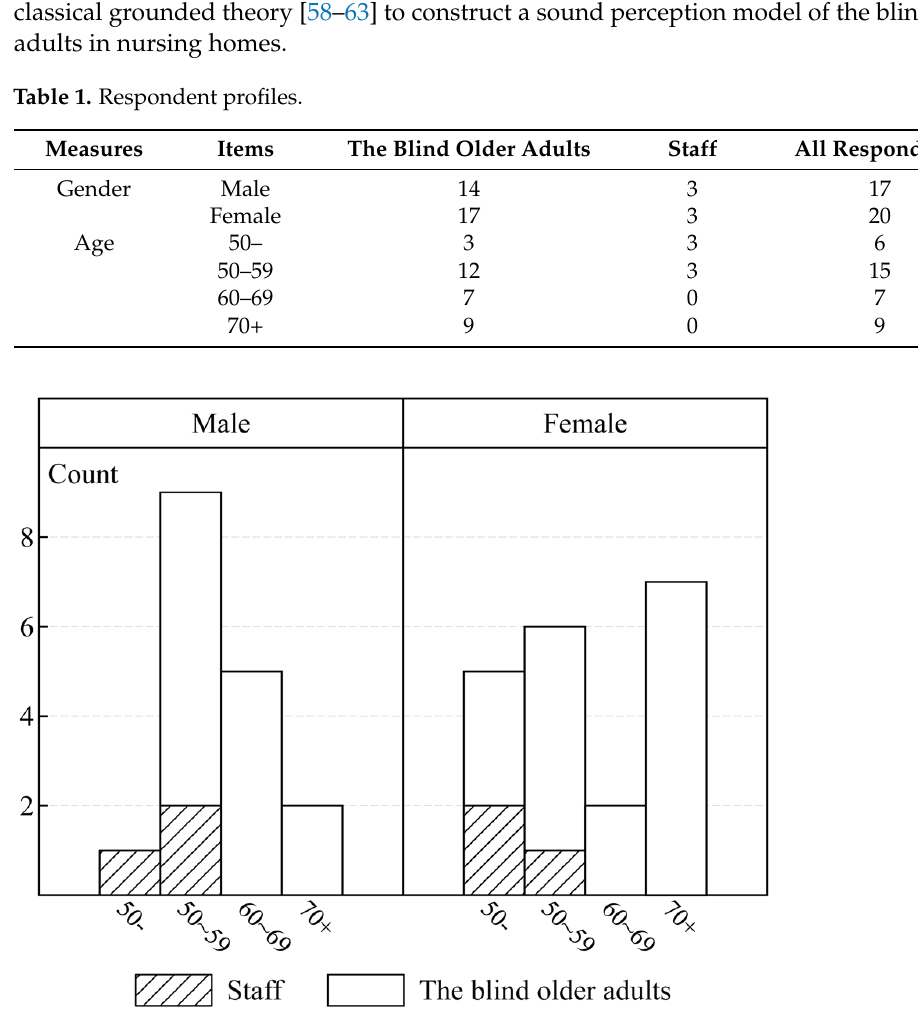
Figure 3. Age and sex distribution of the respondents.